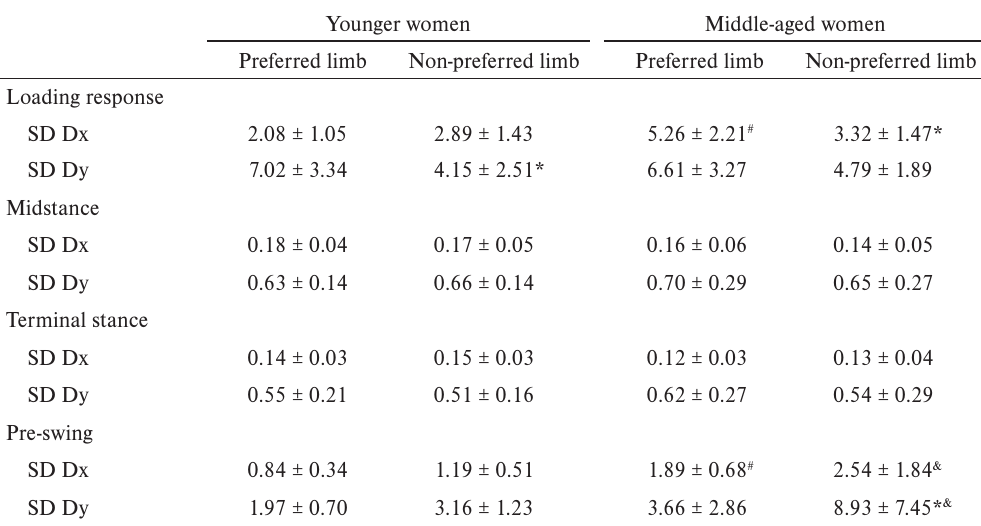
Observed gait variables for preferred and non-preferred limb in different subphases of a stance phase. All values are in millimetres presented as mean ±